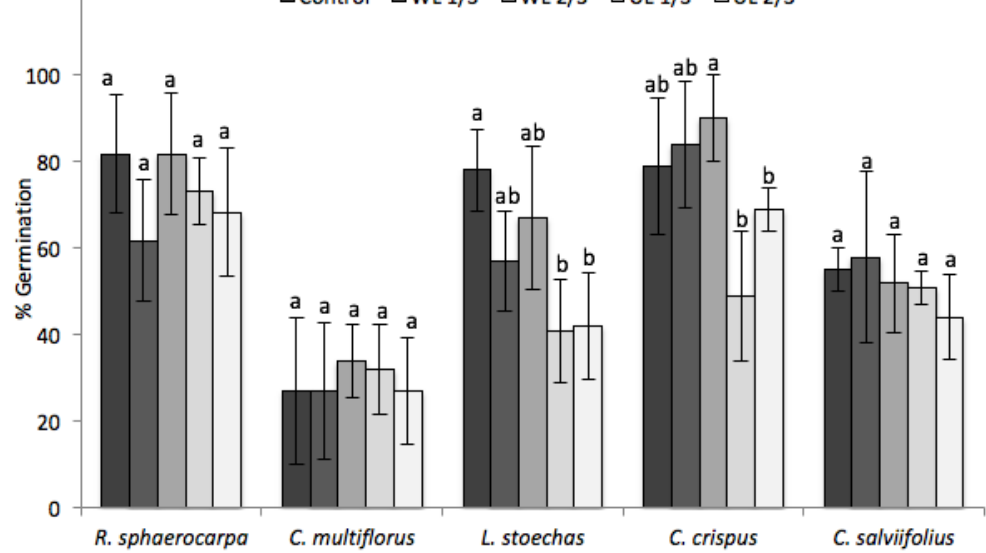
Figure 1. Effect of leaf litter on the germination percentage of the analysed species in the five treatments (C: vermiculite control; WL, washed leaf litter; UL: untreated leaf litter; 1/3: 1.33 dm 3 of vermiculite and 0.66 dm 3 of leaf litter; 2/3: 0.66 dm 3 of vermiculite and 1.33 dm 3 of leaf litter). a, b: same letter means no significant difference between treatments ( p > 0.05).